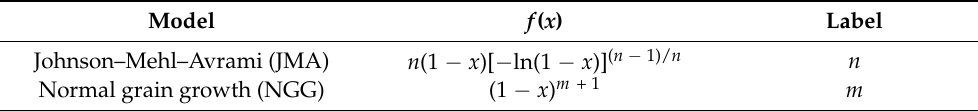
Figure 7. Curves representing crystallization mechanisms of ( a ) Zr54 BMG and ( b ) Zr48Ho6 BMG. Table 4. Theoretical kinetic modes considered.